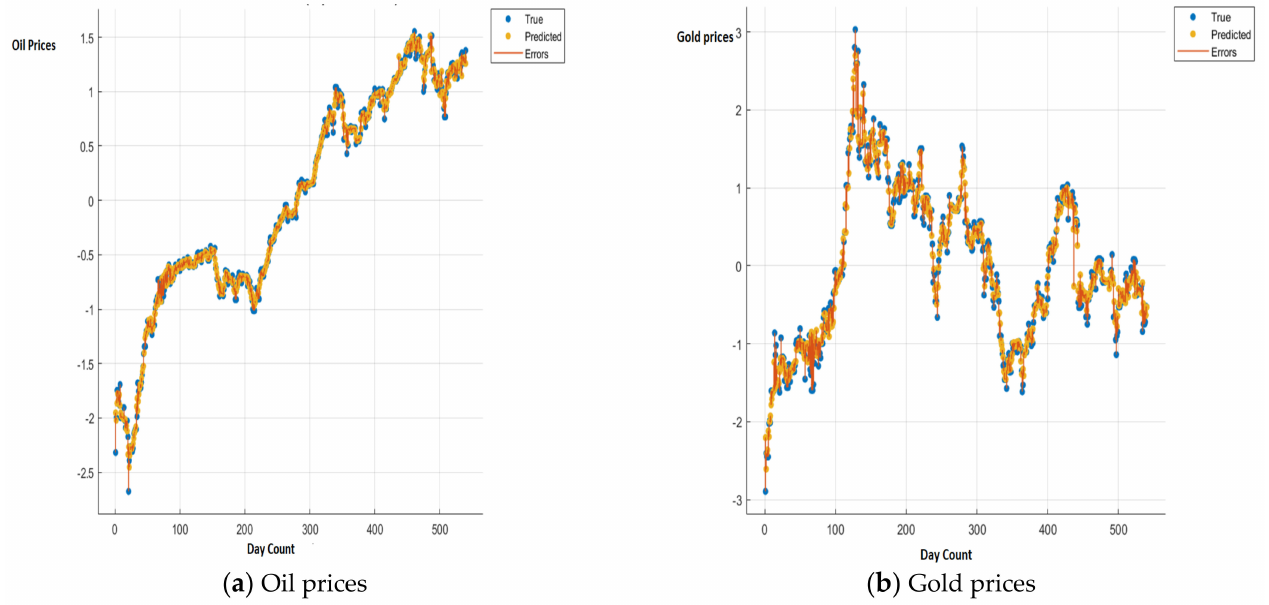
Figure 9. The predicted values versus the true ones for the gold and oil prices versus 540 days during the COVID-19 pandemic using the hybrid feature extraction-based approach and NN regression